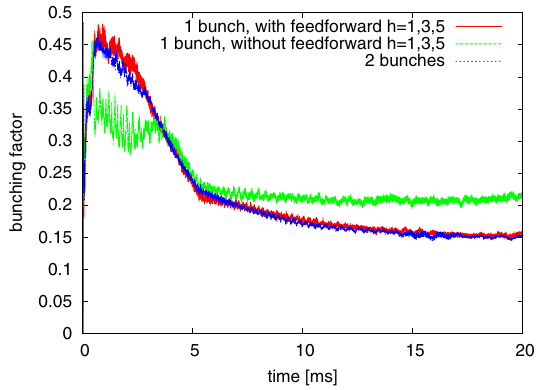
FIG. 7. The bunching factors from injection to extraction in cases of acceleration of a single bunch with and without feedforward for the odd harmonics, and two bunches of 2 . 3 × 10 13 ppb with standard h ¼ 2 ; 4 ; 6 feedforward.